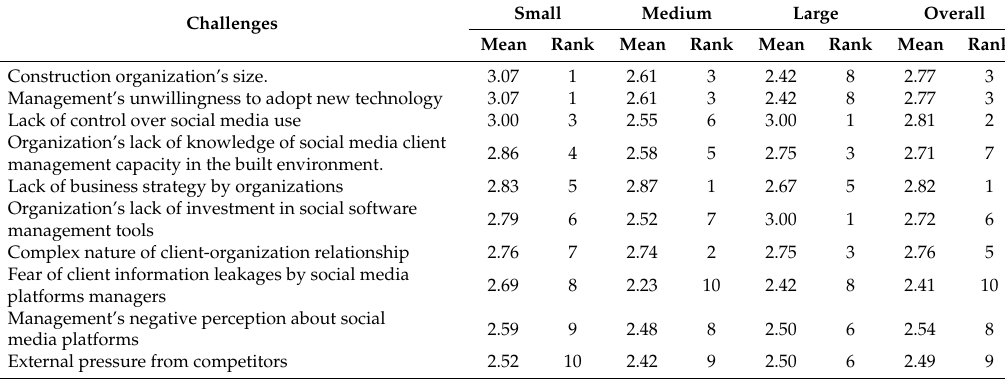
Table 5. Challenges confronting small, medium, and large construction organizations in the adoption of CRM 2.0.